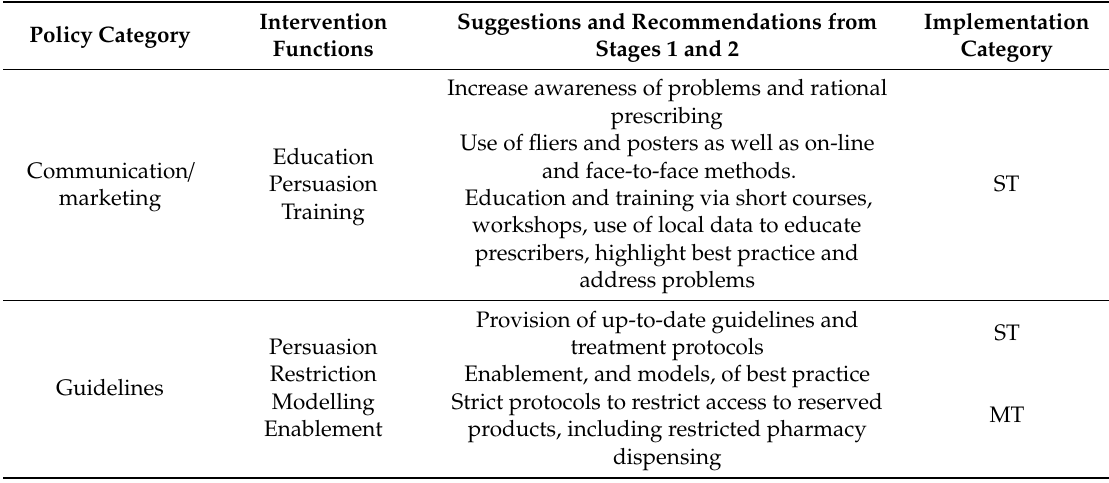
Table 3. Draft framework for AMS showing application of the Behaviour Change Wheel (BCW) policy categories, intervention functions, and specific